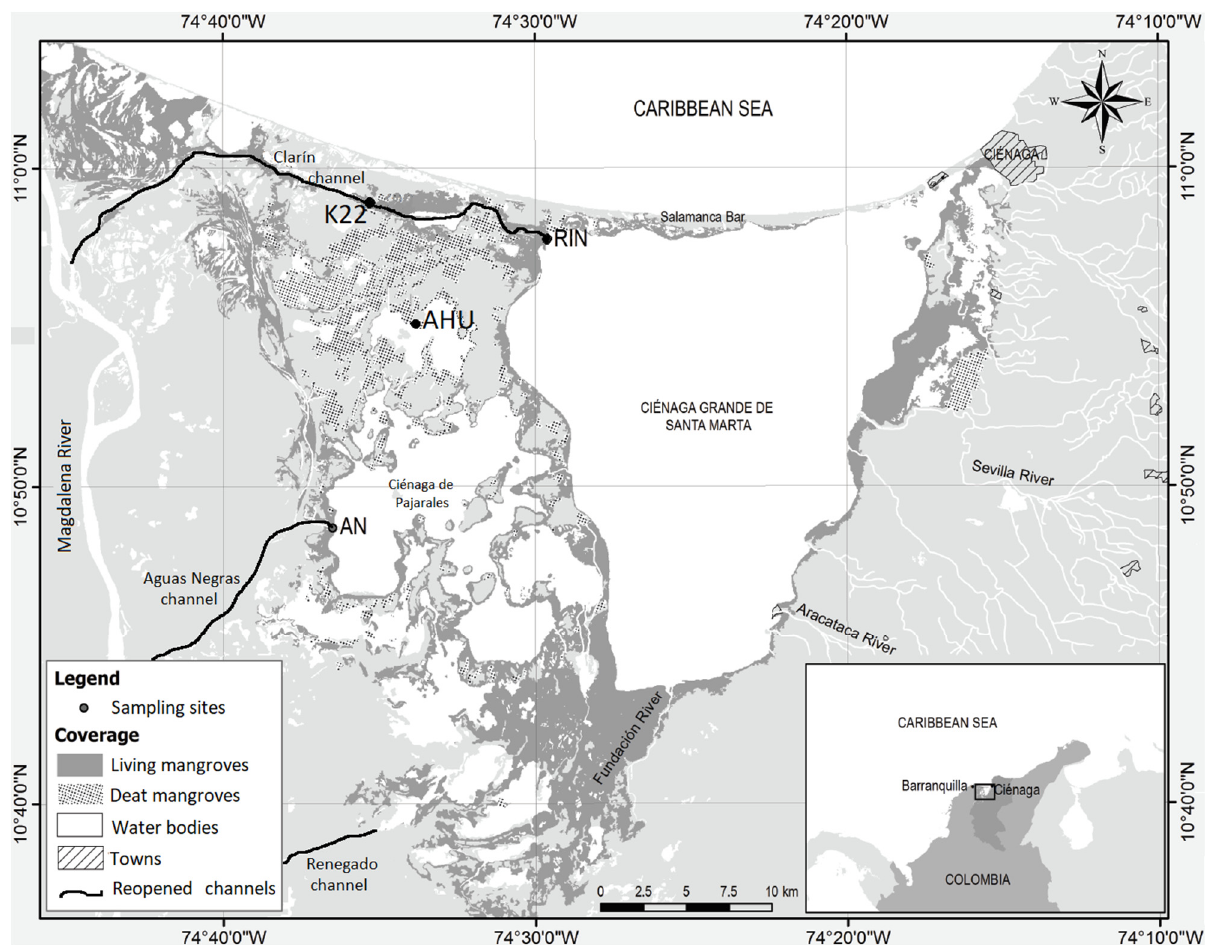
Figure 1. Sampling sites in the Ciénaga Grande de Santa Marta lagoon system. (Map by David Morales-Giraldo and Nicolás Castro-Perdomo).